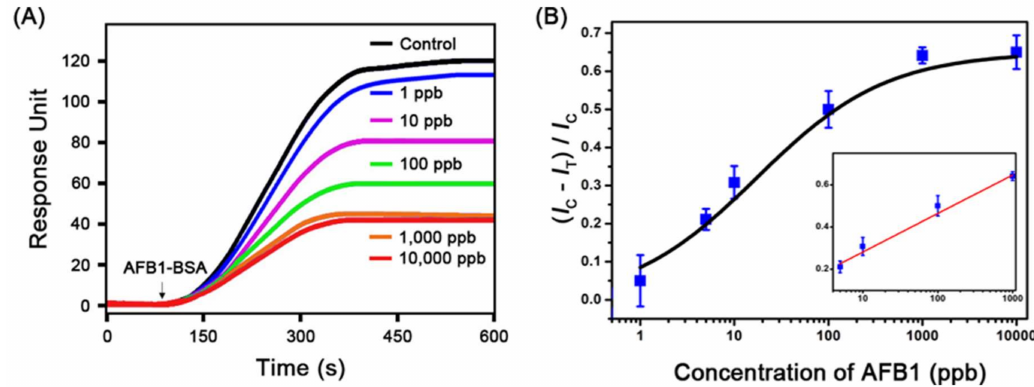
Figure 3. ( A ) SPR response curves obtained in the control channel (black line) and test channels by varying the AFB1 concentration (1, 10, 100, 1000, and 10,000 ppb). The SPR response intensity decreased with increasing AFB1 concentration because the amount of bound AFB1-BSA is inversely proportional to the AFB1 concentration. ( B ) Plot of ( I C − I T )/ I C versus the concentration of AFB1. I C and I T represent the mean SPR response intensity in the control and test channels, respectively. The red linearly fitted line. The data represent the mean plus standard deviation from three